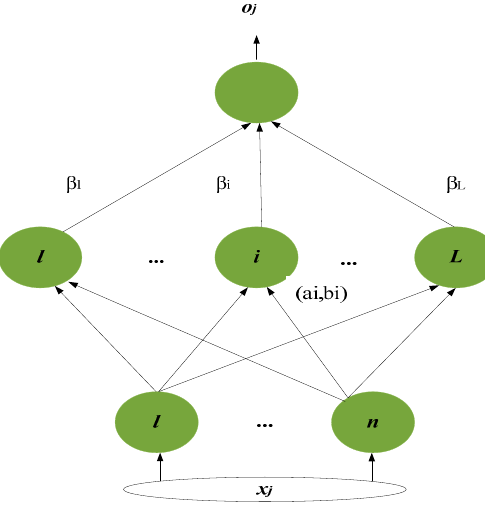
Figure 3. The structure of the ELM.